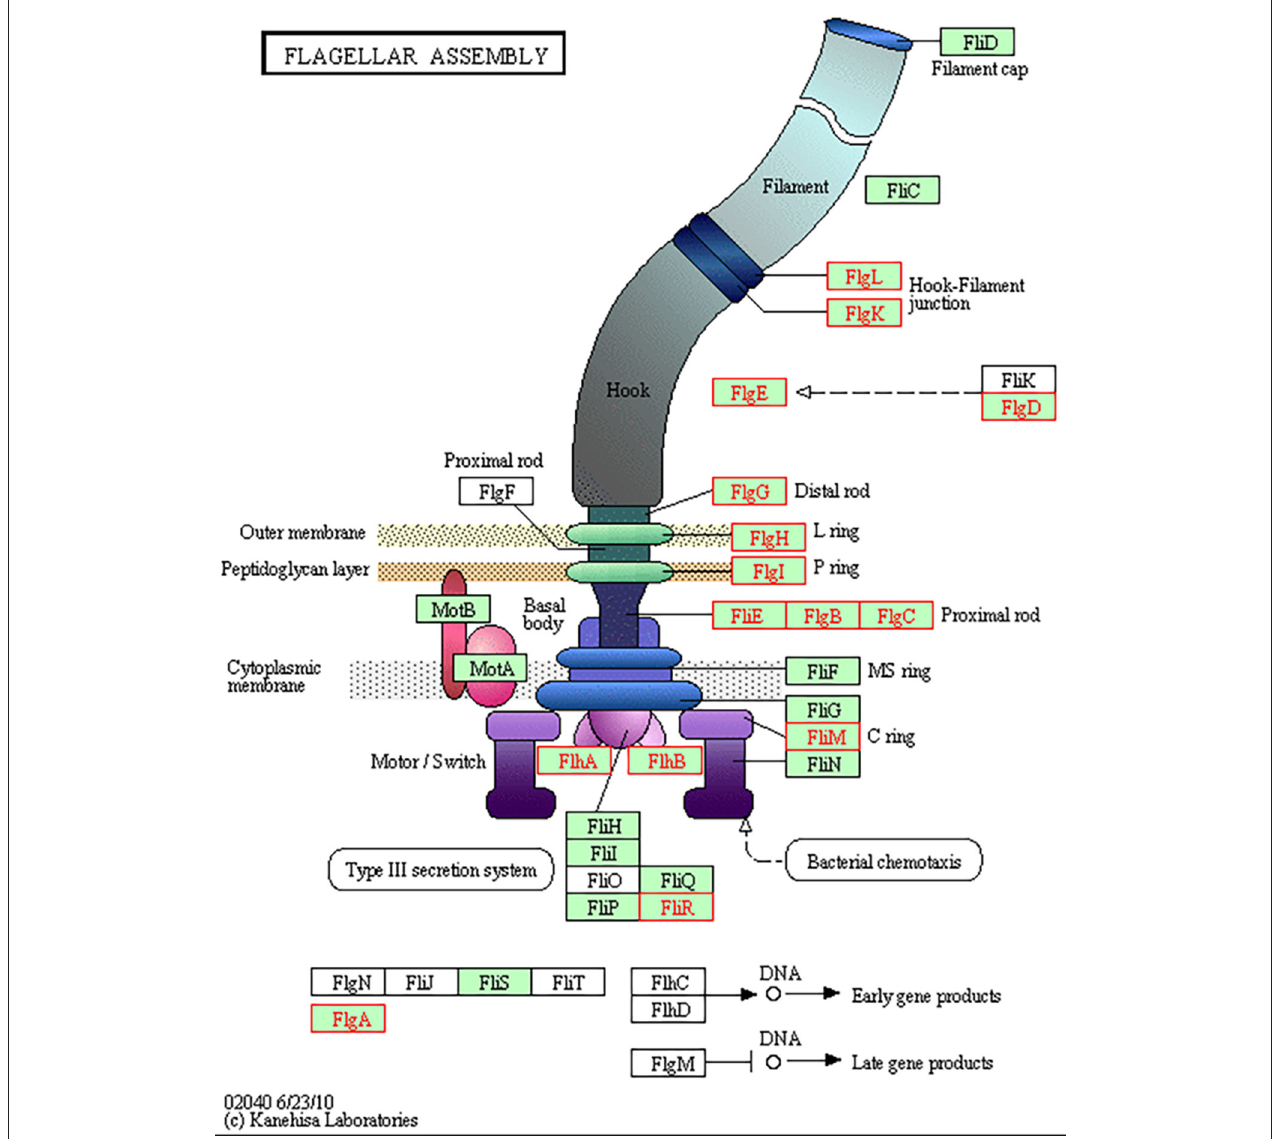
FIGURE 4 | KEGG Pathway for flagellar assembly in C. jejuni. Multiple genes responsible for flagellar assembly were observed to be upregulated in the gallbladder condition only; image depicts 24 h in the in vivo gallbladder environment (increased differential expression denoted by red